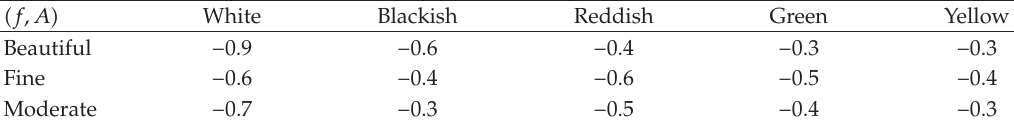
Table 3: Tabular representation of (cid:2) f,A (cid:3)